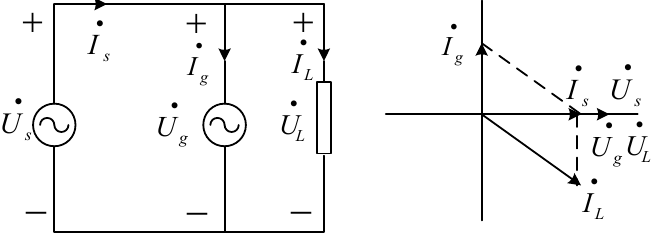
Figure 6. Equivalent circuit and vector diagram for EV system connected to an inductive